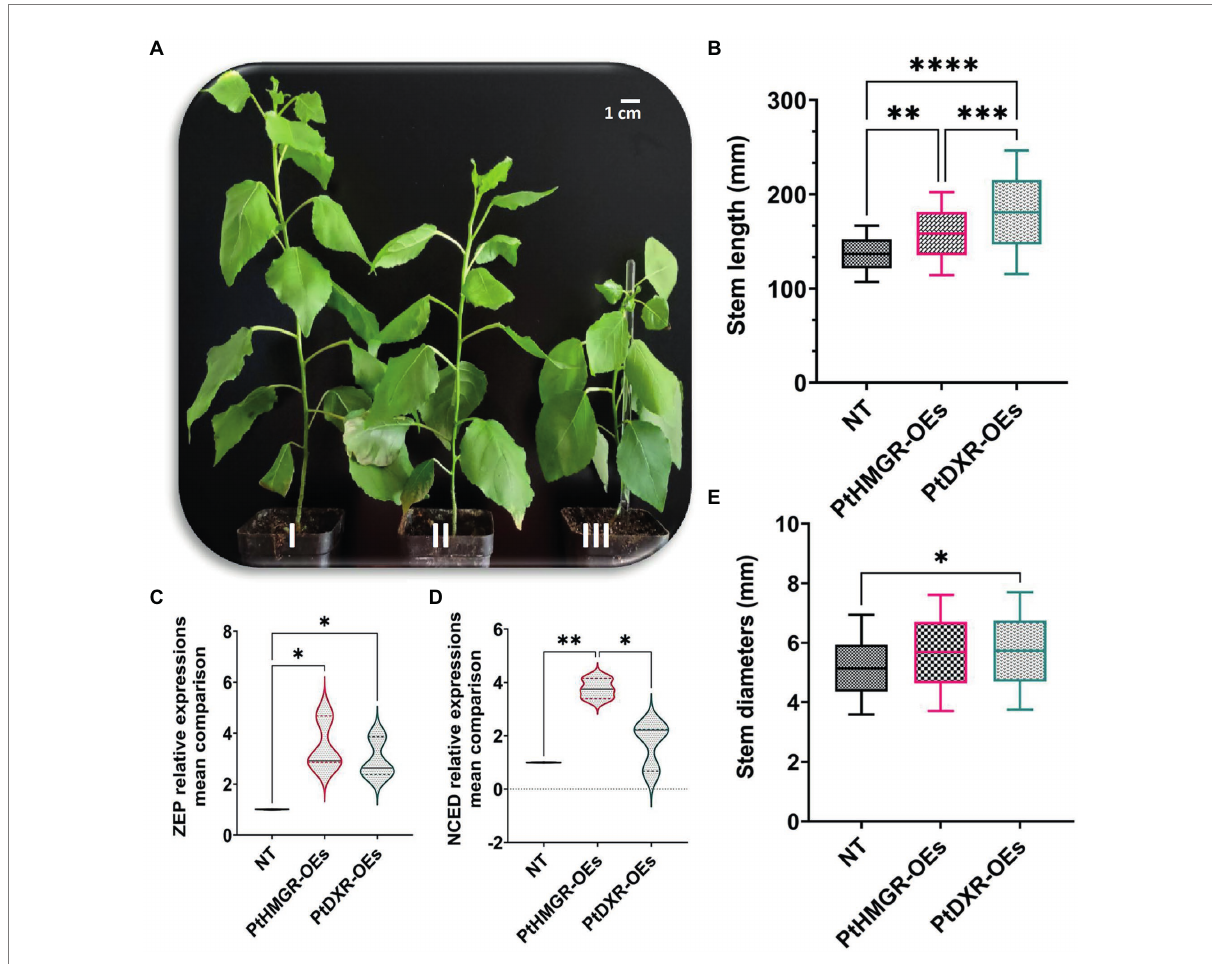
FIGURE 6 Phenotypic changes analyses resulted from the overexpression of PtHMGR and PtDXR effects on MVA and MEP pathways. ( A , I), The PtDXR transgenic revealed a higher stem length than PtHMGR -OEs and NT poplars. ( A , II), The PtHMGR transgenic presents more stem development than NT poplar. ( A , III), NT poplar was used as a control; Scale bar represents 1 cm. (B) The Box and Whisker mean comparison plot of stem lengths revealed significantly higher lengths of PtDXR -OEs than NT poplars compared with PtHMGR -OEs. PtHMGR transgenics also revealed significantly higher lengths than NT poplars. (C,D) The Violin mean comparison plots of ZEP and NCED relative expressions between PtHMGR-and PtDXR -OEs compared with NT poplars. (E) The Box and Whisker mean comparison plot of stem diameters revealed slightly more diameters between PtDXR - OEs and NT poplars. Stars reveal significant differences, * p < 0.05, ** p < 0.01, *** p < 0.001, **** p <